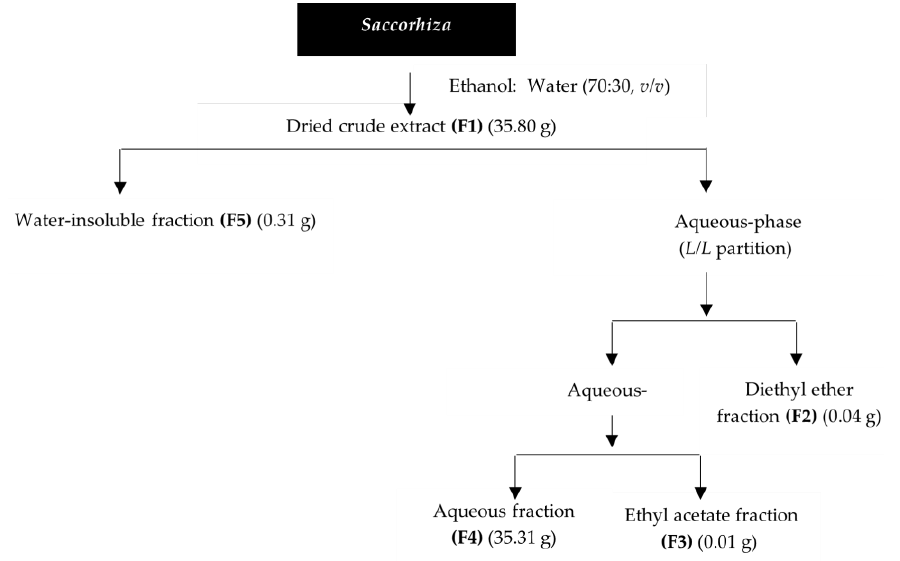
Figure 1. Saccorhiza polyschides extraction flowchart.